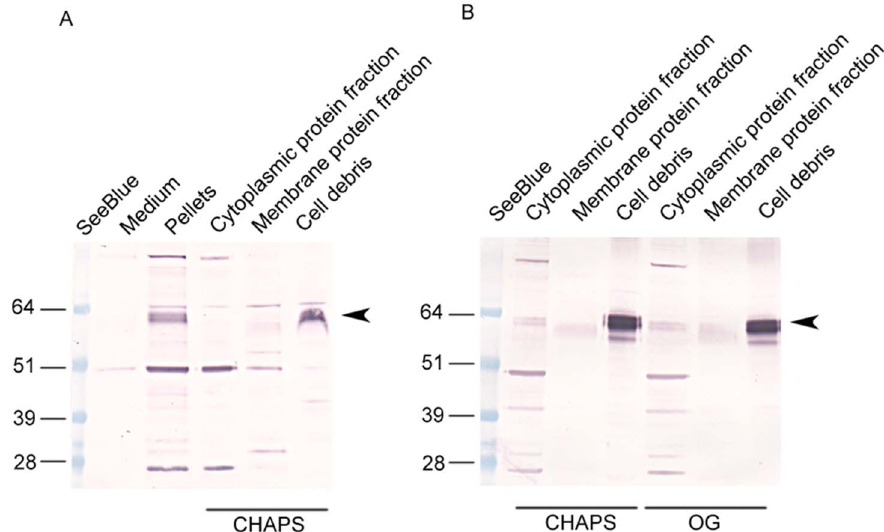
Figure 3. Expression and immunoblot analysis of recombinant full length AgMCORP. A) Membrane proteins were extracted using DUALXtract total membrane protein extraction kit (Dualsystems Biotech). After 24 h expression, cells were pelleted by centrifugation. Both the supernatant and pellets were analyzed. Full length AgMCORP (66 kDa) was not detected in the medium, but was present in pellets. After extraction by CHAPS, AgMCORP was not in the cytoplasmic protein fraction or extractable membrane protein fraction, but in the cell debris. B) Membrane proteins were extracted using a different procedure. The procedure included sonication and ultracentrifugation to separate cytoplasmic proteins and membrane proteins. Two mild detergents, CHAPS and OG (octyl- b -gluside), were used to extract the membrane fraction. AgMCORP was not extracted by the detergents and remained in the cell debris fraction.